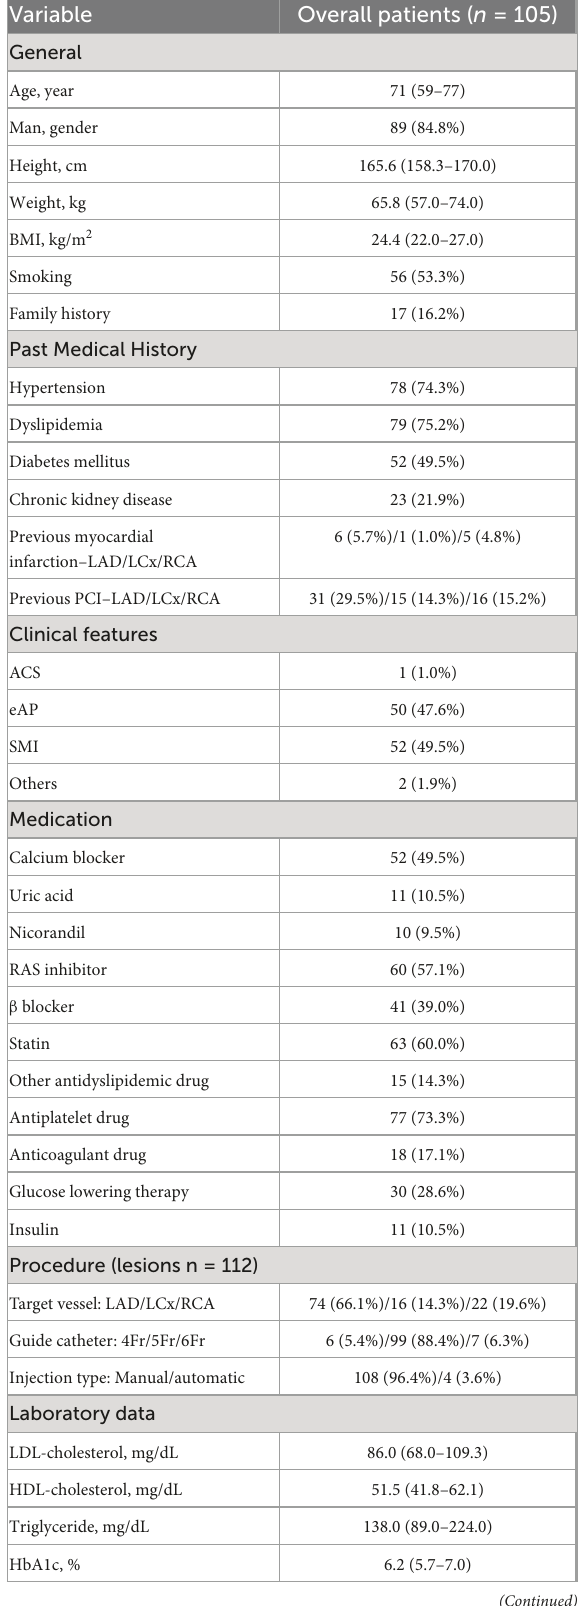
TABLE 1 Baseline